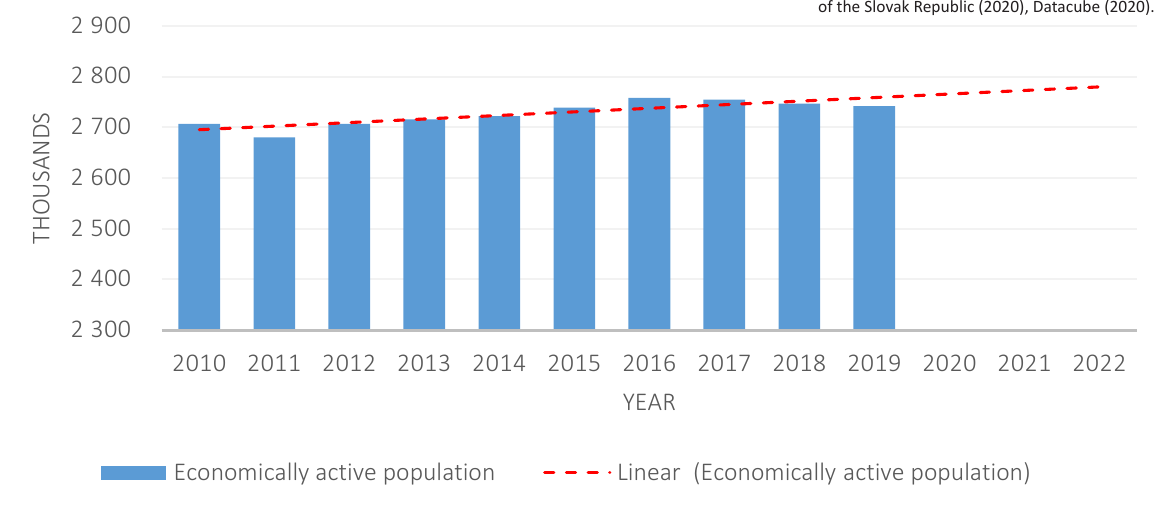
Figure 1. Economically active population (EAP) in Slovak